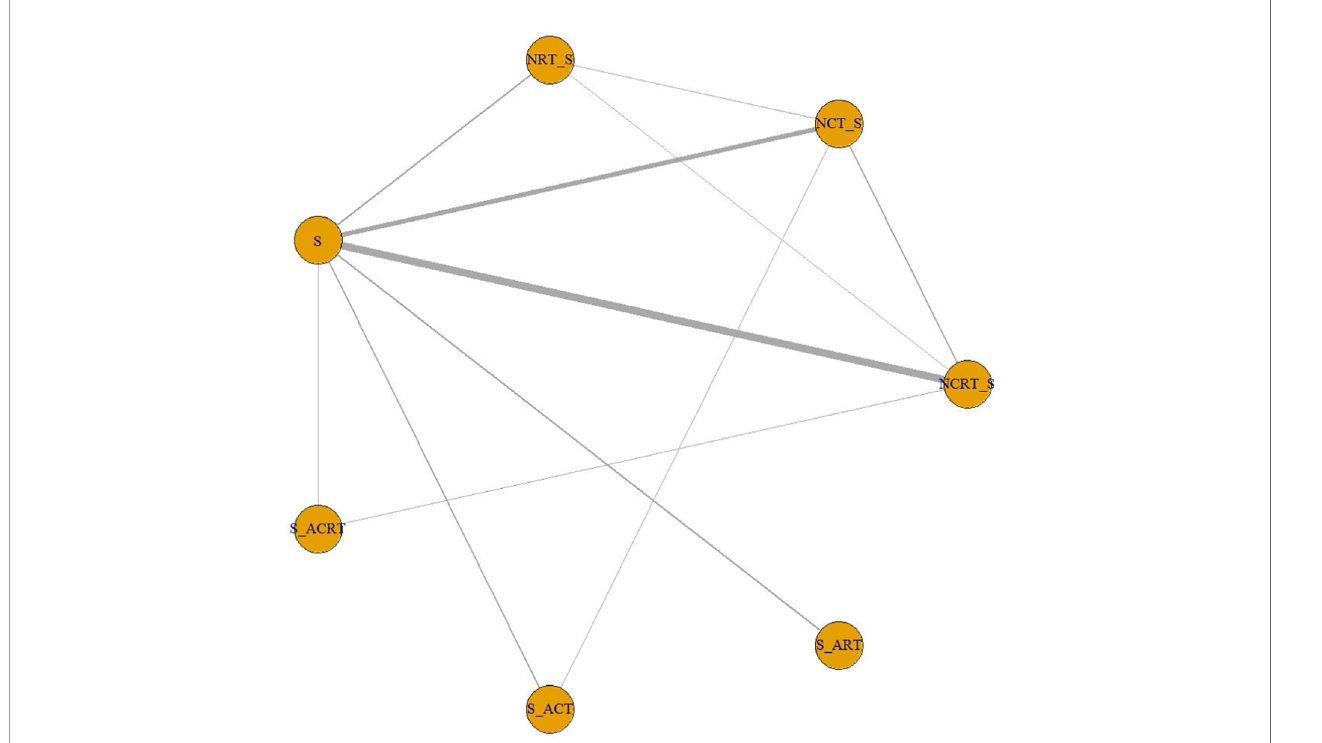
FIGURE 2 | Network plot showing the following different treatment modalities for patients with esophageal squamous carcinoma. The node size is proportional to the total number of patients receiving speci fi c treatment. Each line represents a type of head-to-head comparison. The width of lines is proportional to the number of trials comparing the connected treatments. S, surgery; NCT_S, neoadjuvant chemotherapy followed by surgery; NRT_S, neoadjuvant radiotherapy followed by surgery; NCRT_S, neoadjuvant chemoradiotherapy followed by surgery; S_ACT, surgery followed by adjuvant chemotherapy; S_ART, surgery followed by adjuvant radiotherapy; S_ACRT, surgery followed by adjuvant